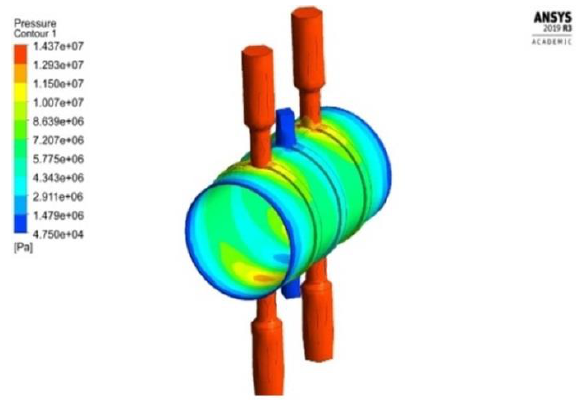
Fig. 10. Pressure distribution inside oil film 4